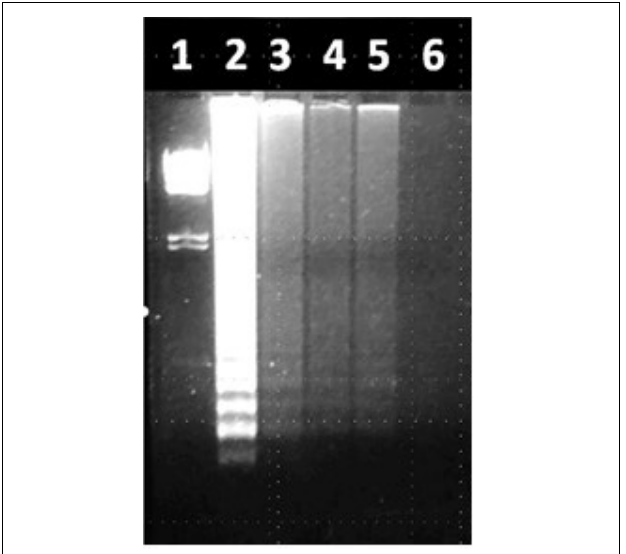
FIGURE 5 | Use of LAMP to detect Salmonella spp. in environmental samples ( fimY target). Lane 1, lambda Hin dIII marker. Lane 2, water spiked with S. typhimurium (positive control). Lane 3, Alley Pond water. Lane 4, standing water in the QCC parking lot. Lane 5, soil at QCC resuspended in water. Lane 6, distilled water (negative control).